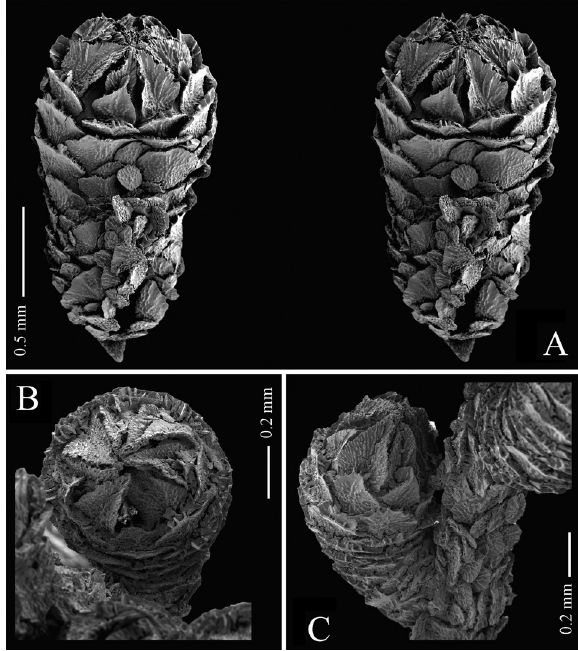
Fig . 4. – Thouarella regularis (Wright and Studer, 1889), lectotype (NHMUK 1889.5.27.60): A, polyp on adaxial view, stereo pair; B, polyp on oral view; C, polyp on latero-adaxial